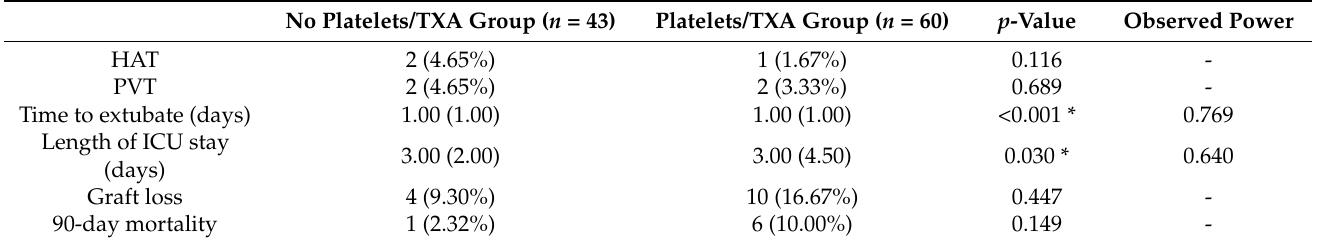
Table 7. Postoperative outcomes of LT patients categorised by combined treatment of platelets and